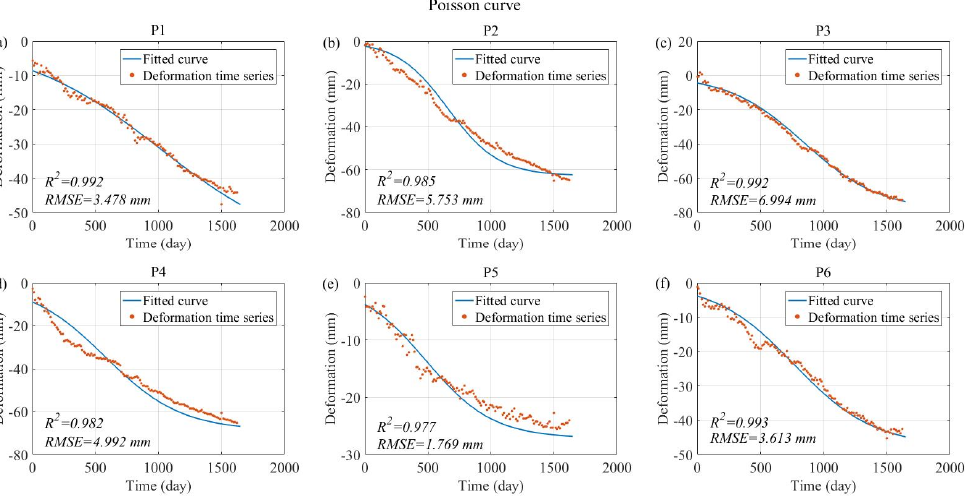
Figure 6. Poisson curve fitting of ( a ) P1, ( b ) P2, ( c ) P3, ( d ) P4, ( e ) P5 and ( f ) P6. Locations of points P1−P6 are shown in Figure A1.